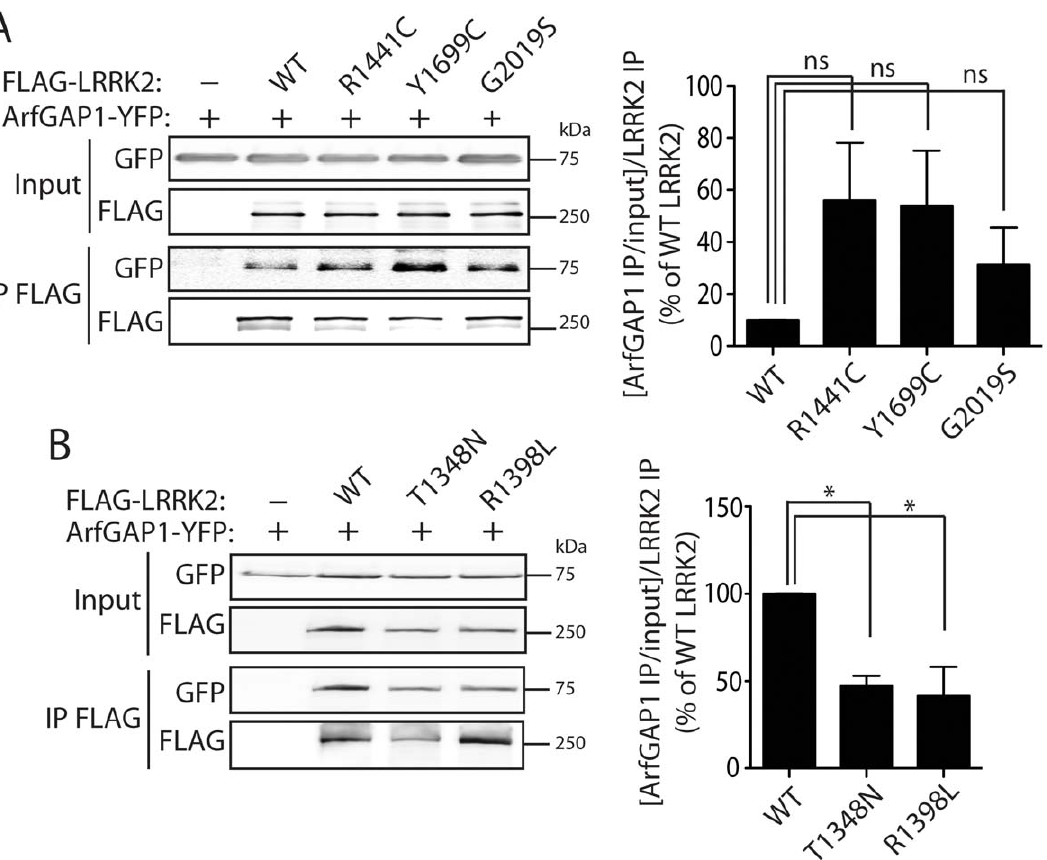
Figure 4. Familial PD–associated and functional mutations in LRRK2 modulate the interaction with ArfGAP1. (A) Differential interaction of YFP-tagged ArfGAP1 with WT and PD-associated mutant forms of FLAG-tagged human LRRK2 following IP with anti-FLAG antibody from HEK-293T cells. Densitometric analysis reveals a non-significant increase in the interaction of ArfGAP1 with R1441C, Y1699C and G2019S LRRK2 compared to WT LRRK2. (B) Functional GTPase mutations in FLAG-LRRK2 impair the interaction with ArfGAP1-YFP following IP with anti-FLAG antibody from HEK-293T cells. Densitometry reveals a significant reduction of the interaction of ArfGAP1 with T1348N and R1398L LRRK2 compared to WT LRRK2. Data represent the level of interaction of ArfGAP1 with LRRK2 expressed as a percent of the interaction with WT LRRK2. The levels of ArfGAP1 IP were first normalized to ArfGAP1 input levels, and then further normalized to LRRK2 IP levels. Bars represent the mean 6 SEM ( n =3 experiments). * P , 0.05 compared to WT LRRK2 by one-way ANOVA with Newman-Keuls post-hoc analysis. ns ,